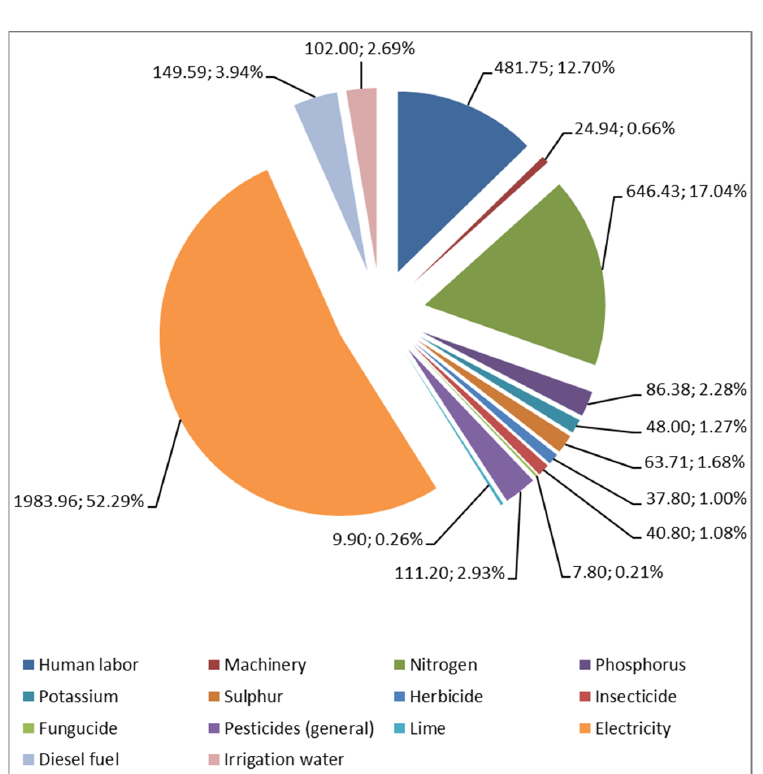
Figure 3. Distribution of greenhouse gas emissions in orange production (kg CO 2–eq ha − 1 ; %).